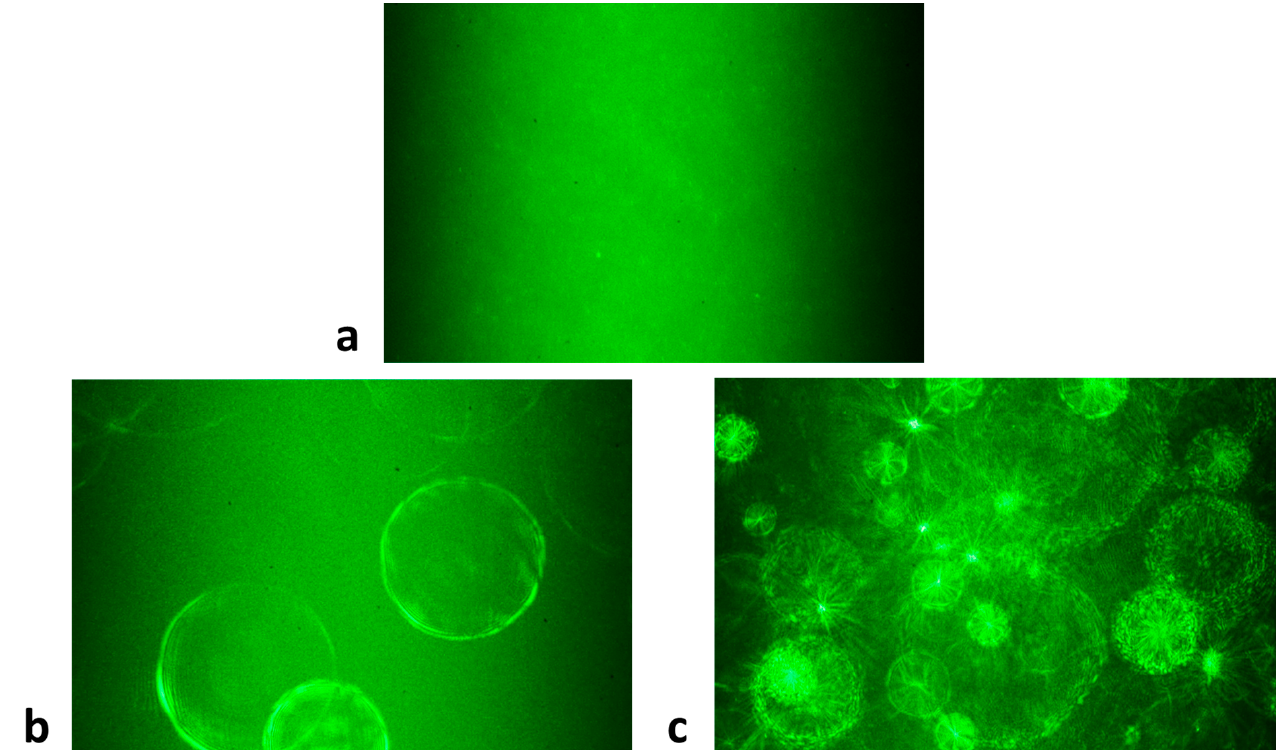
Figure 6. Scattering patterns of monochromatic green semiconductor laser light, passing through: ( a ) citrate-stabilized silver nanoparticles; ( b ) silver nanoparticles covered with a large protein corona (variant 1); ( c ) nanoparticle aggregates (variant 2).